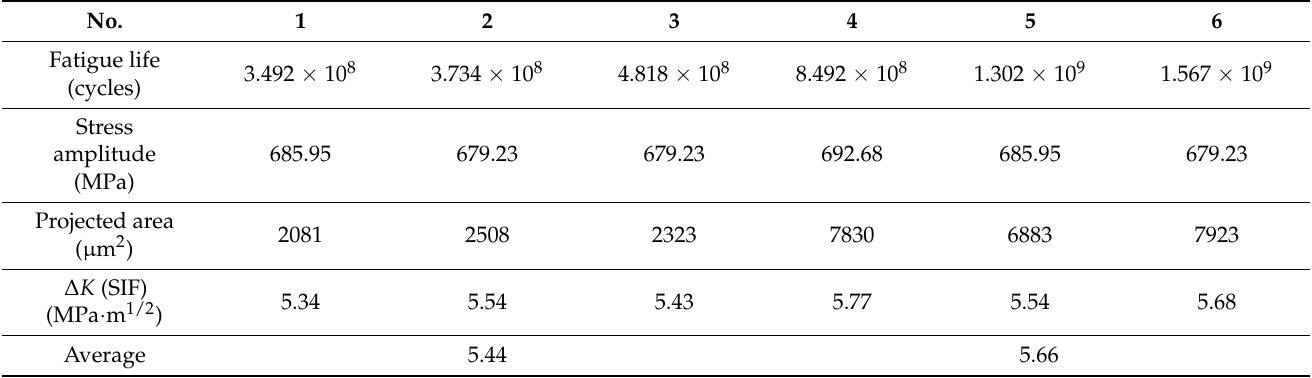
Table 2. ∆ K value of cracks initiating from surface and internal defects